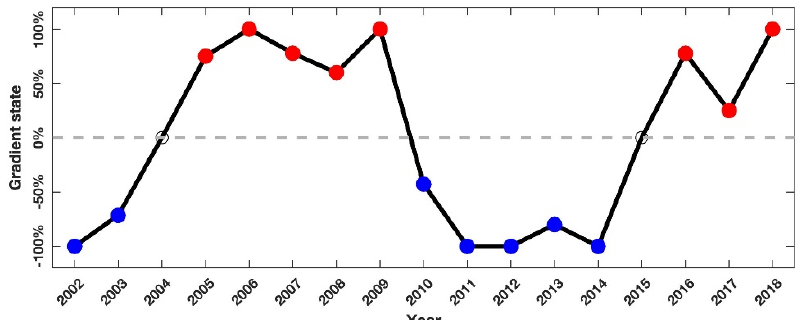
Figure 9. Gradient state based on the annual percentage of the anomaly in the SST gradient magni- tude. Red (blue) dots indicate a high percentage of large positive (negative) anomalies in SST gradient magnitudes. The dashed gray line represents the percentage where the positive and negative SST gradient magnitudes are equal, with hollow dots indicating a neutral state. If more than 50% of the time in a year the month is characterized as a near-zero anomaly in SST gradient magnitude, the corresponding year is also defined as a neutral